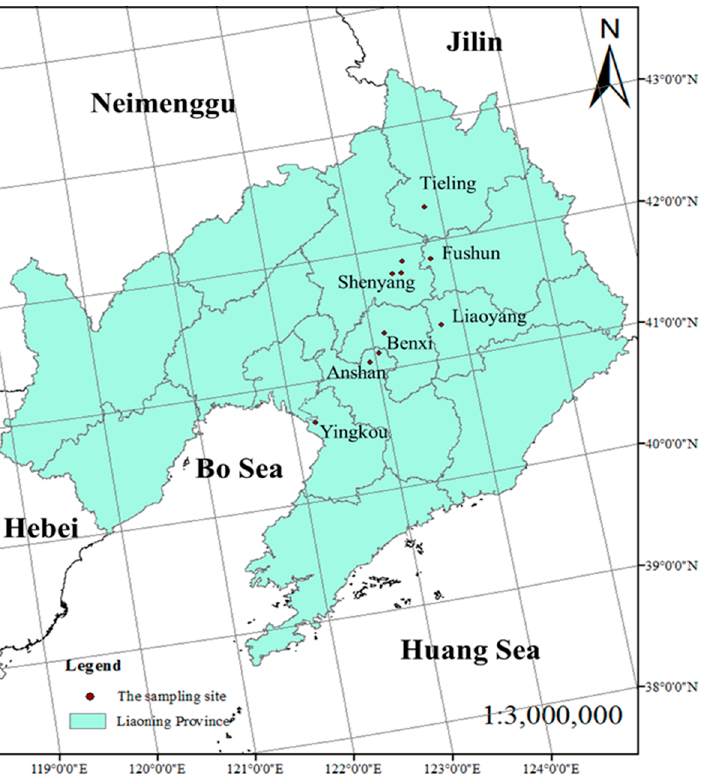
Figure 1. Location of sampling sites ( n = 10) in the seven cities of the urban